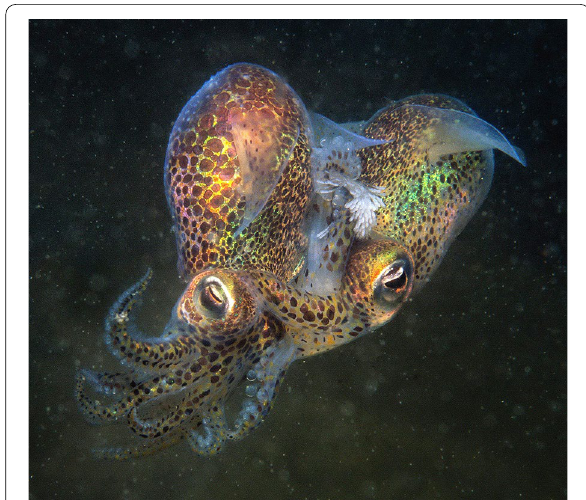
Fig. 5 Mating in Sepiola cf. atlantica in the field (female to the left). A bunch of white spermatophores can be seen held by the male’s